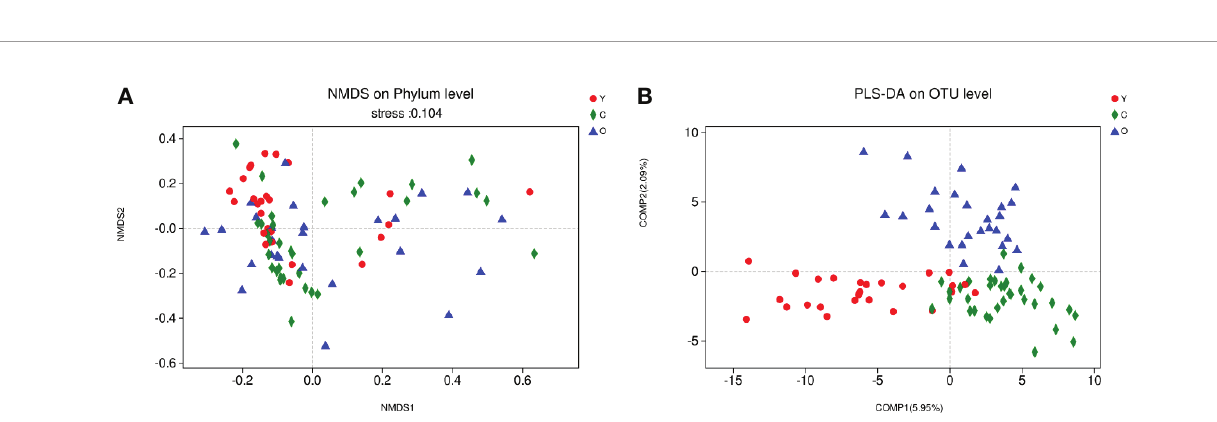
FIGURE 2 | The community difference among the three groups. (A) Points of different colors or shapes represent samples of different groups. The closer the two sample points are, the more similar the species composition of the two samples is. Horizontal and vertical coordinates represent relative distances and have no practical signi fi cance. The stress number can verify the merits and demerits of Nonmetric multidimensional scaling (NMDS) analysis results. It is generally believed that stress < 0.2 can be expressed by the two-dimensional dot pattern of NMDS, and our grouping scheme has a certain explanatory meaning on the phylum level. (B) The scale of X and Y axis is relative distance, which has no practical signi fi cance. Comp1 and Comp2 respectively represent the suspected in fl uencing factors that deviate the microbial composition of the three groups of samples. (Y, young volunteers; O, old volunteers; C, CRC